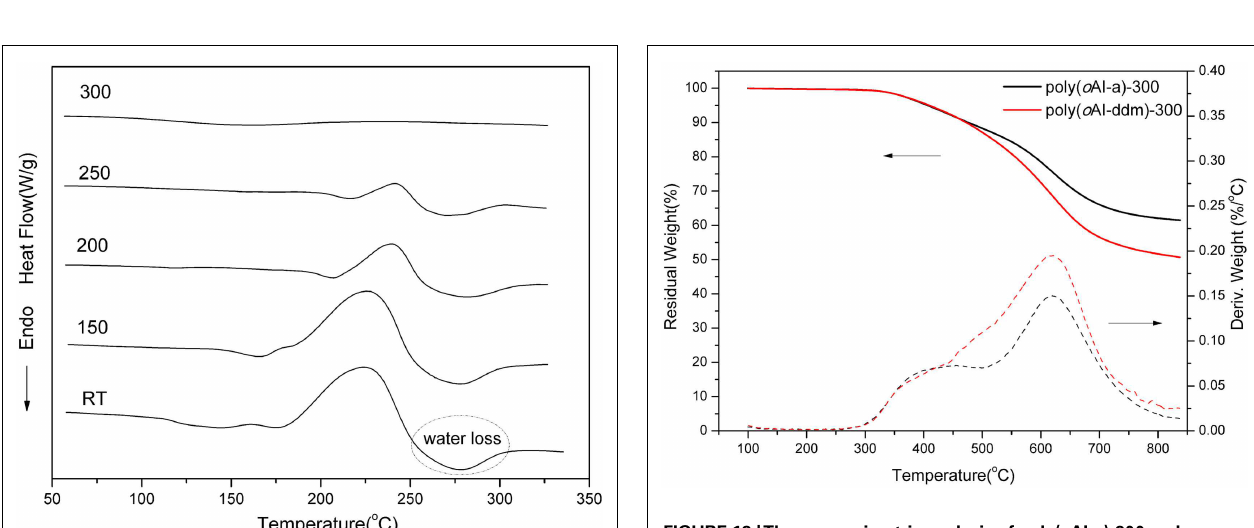
FIGURE 12 |Thermogravimetric analysis of poly( o AI-a)-300 and poly( o AI-ddm)-300 . Table 1 |Thermal properties of poly( o AI-a)-300 and poly( o AI-ddm)-300 .